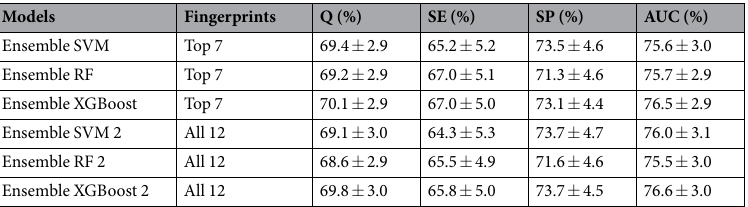
Table 2. Performance of ensemble models in five-fold cross-validation. The performance values are represented as means and standard